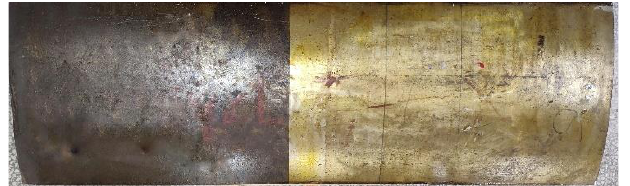
Figure 1. The weld joint between the primary side nozzle of the steam generator and the safe-end.